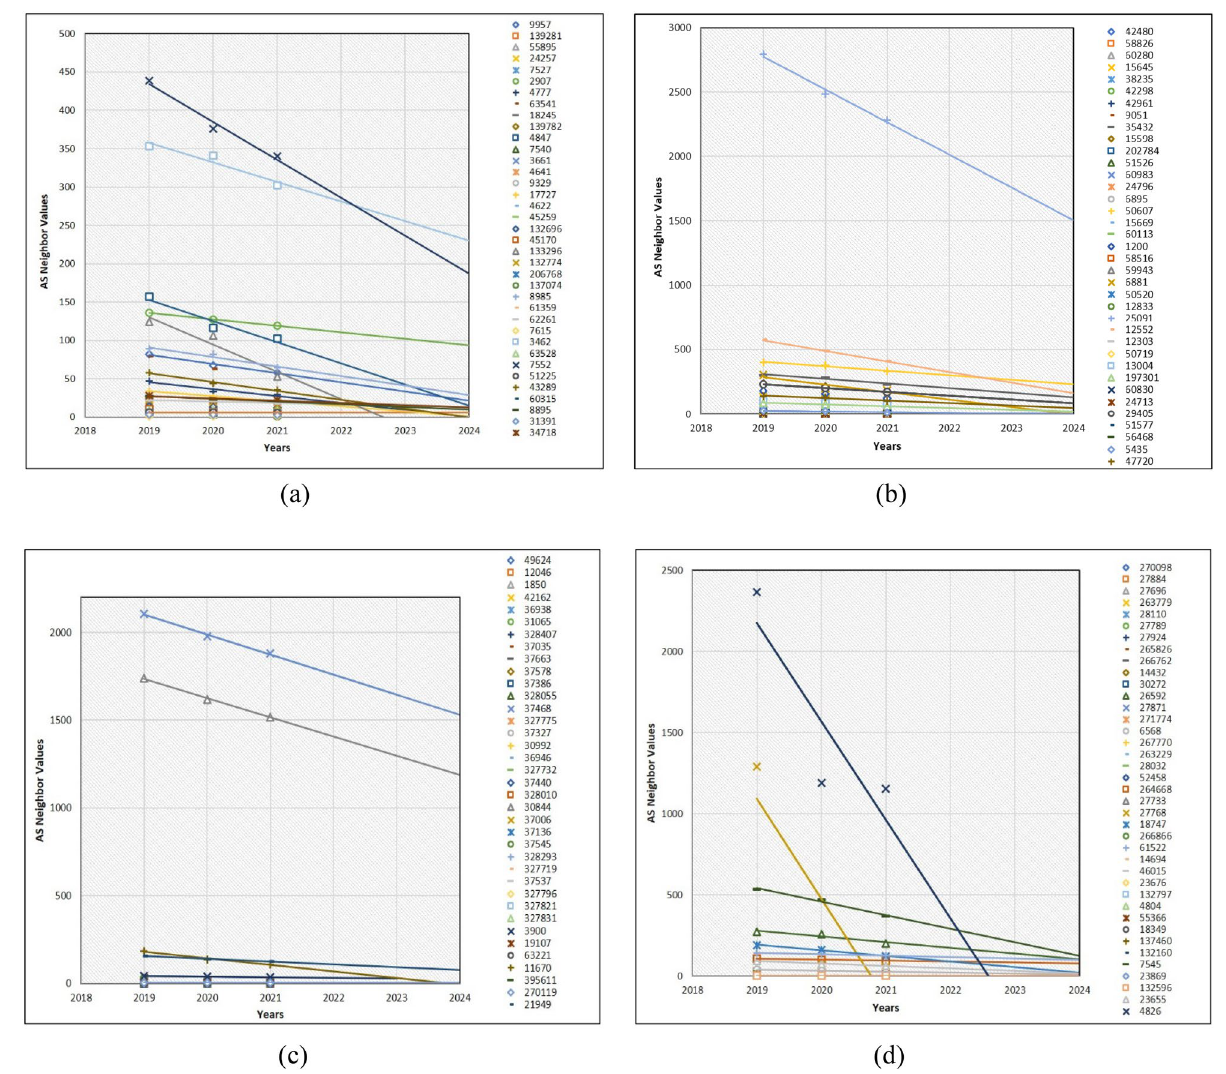
Figure 10. Prediction of 150 IXP-type AS neighbor